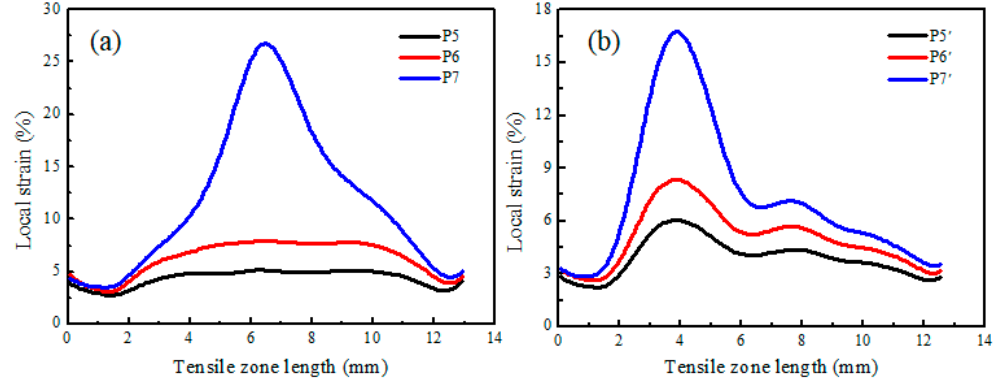
Figure 13. Comparison of the local strain distribution in the gauge section: ( a ) Transversal specimen; ( b ) longitudinal specimen.